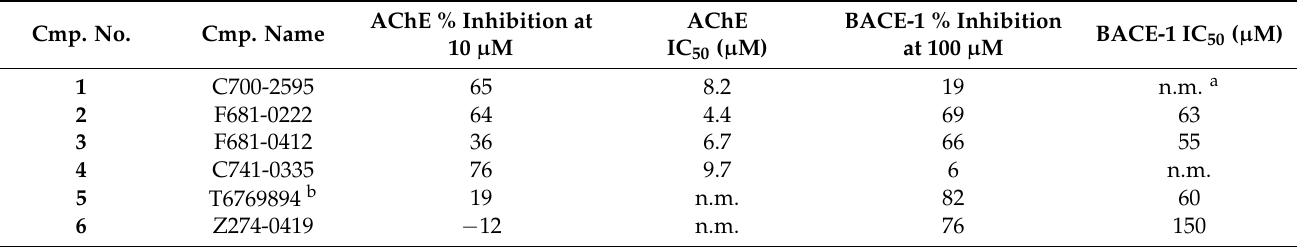
Table 5. Hit compounds on AChE and/or